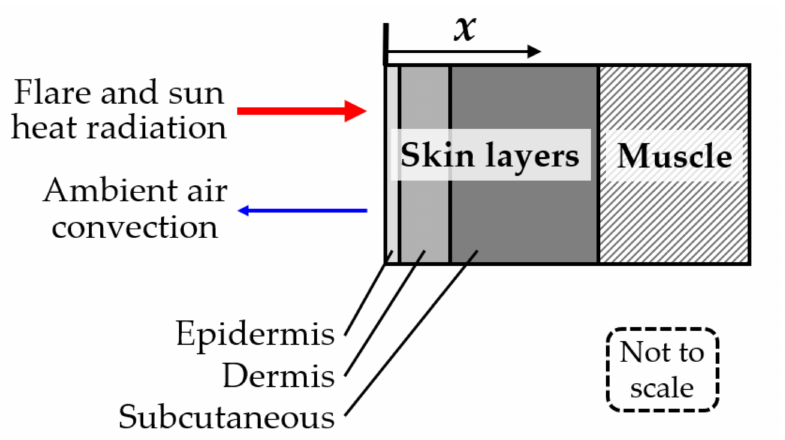
Figure 2. Sketch of the skin and muscle layers and heat fluxes involved in an ignited flare